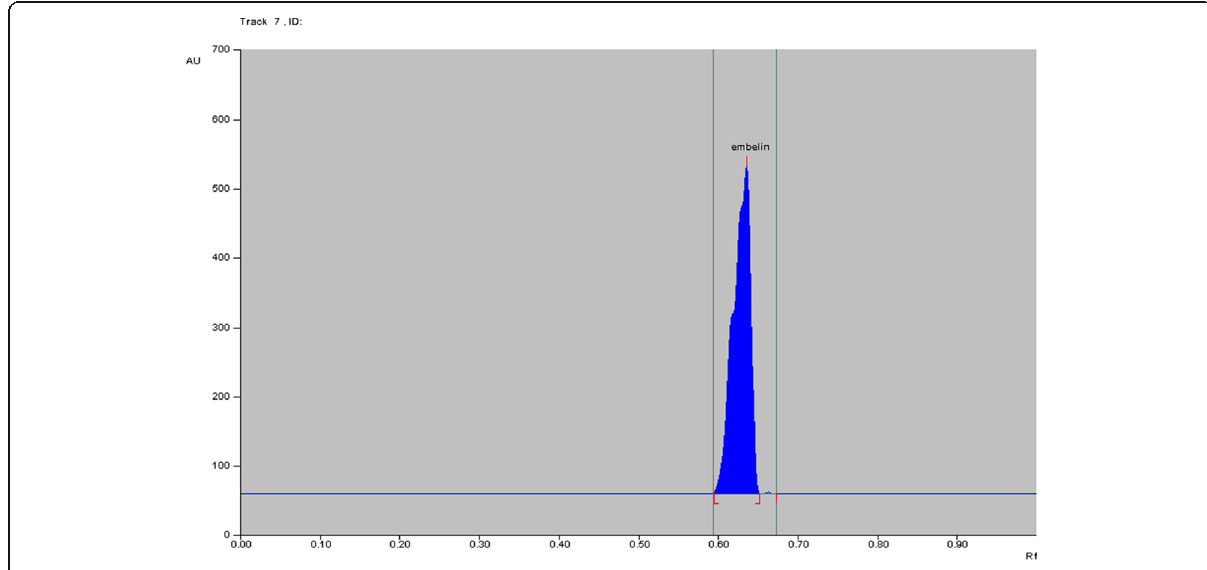
Fig. 8 HPTLC chromatogram of standard embelin at 366 nm